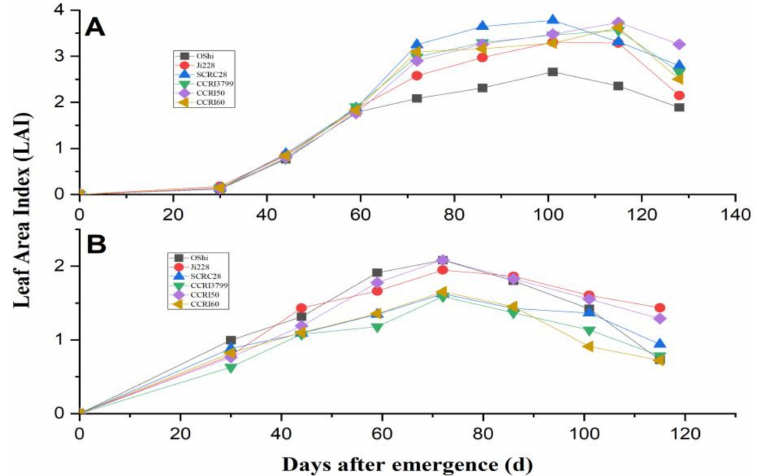
Figure 5. Leaf area index of six varieties in 2018 ( A ) and 2019 ( B